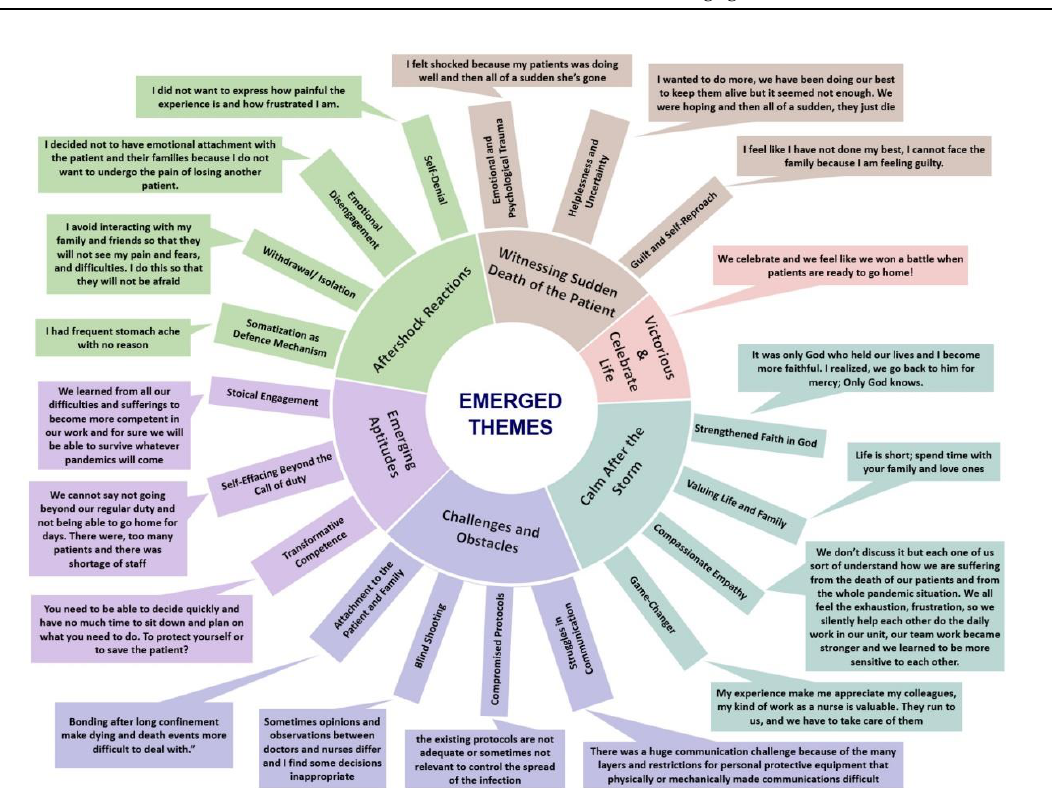
Figure 1. A schematic illustration of emerged themes and subthemes with relevant participants’ quotes. Table 1. Emerged themes and subthemes ( n = 7).